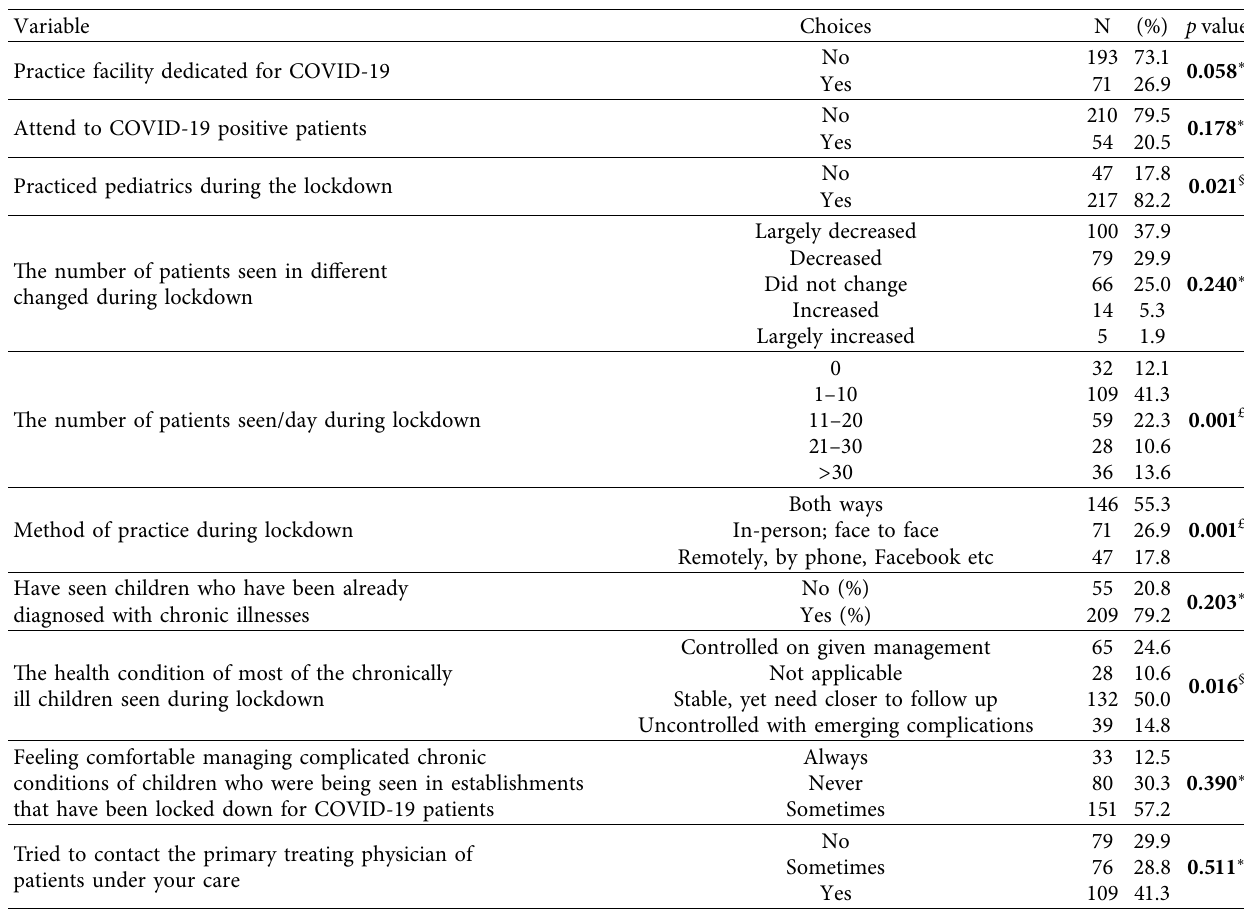
Table 2: Effect of COVID-19 pandemic on health services in